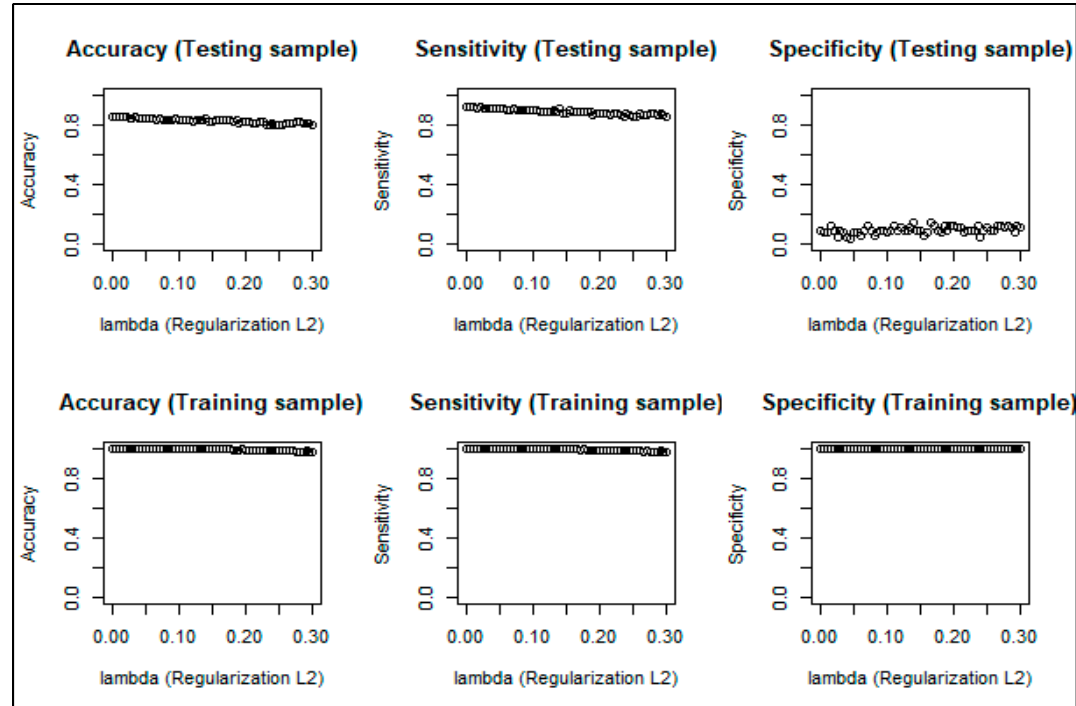
Figure 4. The predictive measures according to λ . L2 method applied to the training and testing samples.